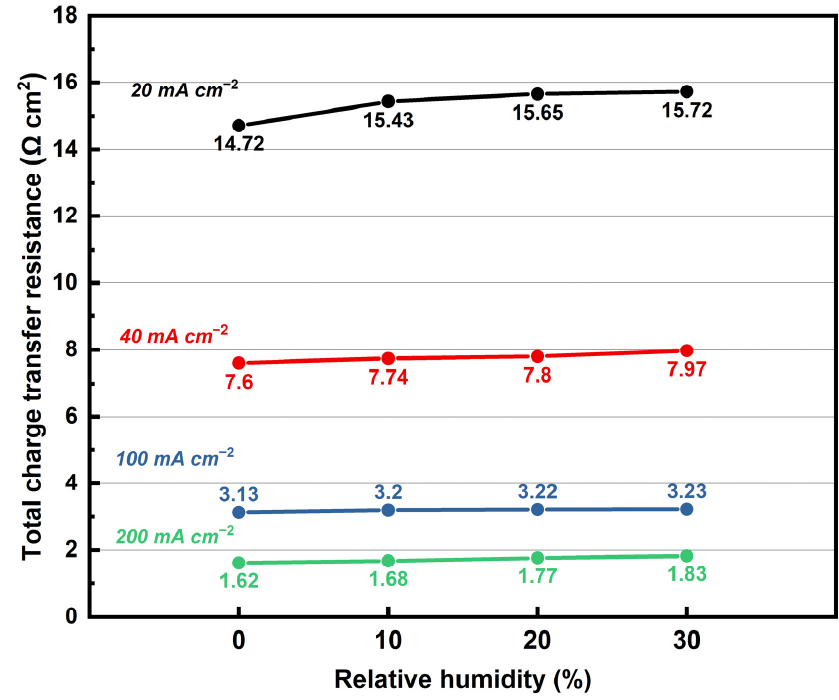
Figure 12. Total charge transfer resistance changing in levels of RH from 0 to 30% for different output constant DC densities (180 °C, equal H 2 and O 2 flow rates at 0.4 L min − 1 ).